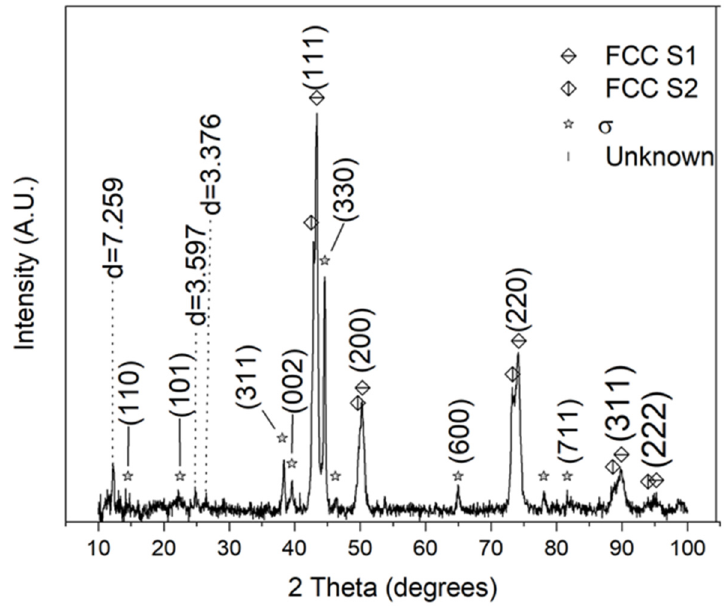
Figure 10. XRD pattern of CrMnFeCoNiCu alloy after slow cooling and exhibiting multiple phases. Figure 10. XRD pa tt ern of CrMnFeCoNiCu alloy after slow cooling and exhibiting multiple phases. For unindexed peaks, the interplanar spacing d is given in angstroms. For unindexed peaks, the interplanar spacing d is given in angstroms. Table 5. Values of mixing enthalpy calculated by Miedem’s model of binary atomic pairs between all constituent elements. Taken from Ref.